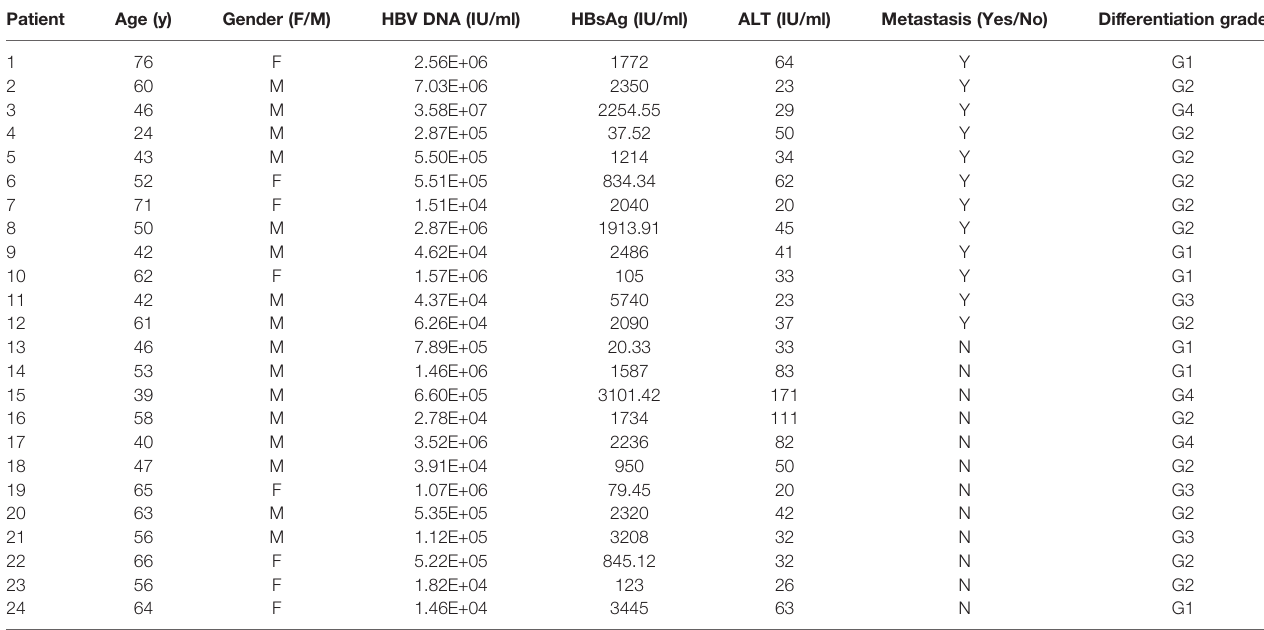
TABLE 1 | Clinical and virological characteristics of the subjects enrolled in the study. Patient Age (y) Gender